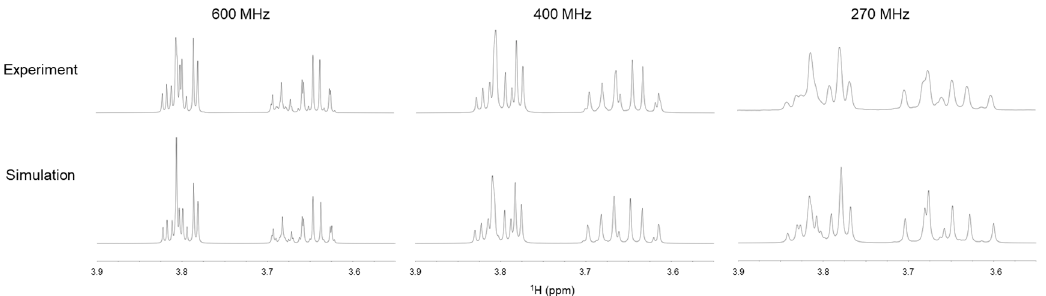
Figure 4. Solution 1 H-NMR spectra of ribitol ( upper ) at 1 H observation frequencies of 600 ( left ), 400 ( middle ), and 270 MHz ( right ). Simulated NMR spectra at each 1 H frequency are shown in the lower panel. Table 2. 1 H and 13 C chemical shift and coupling constant of ribitol determined in this study.